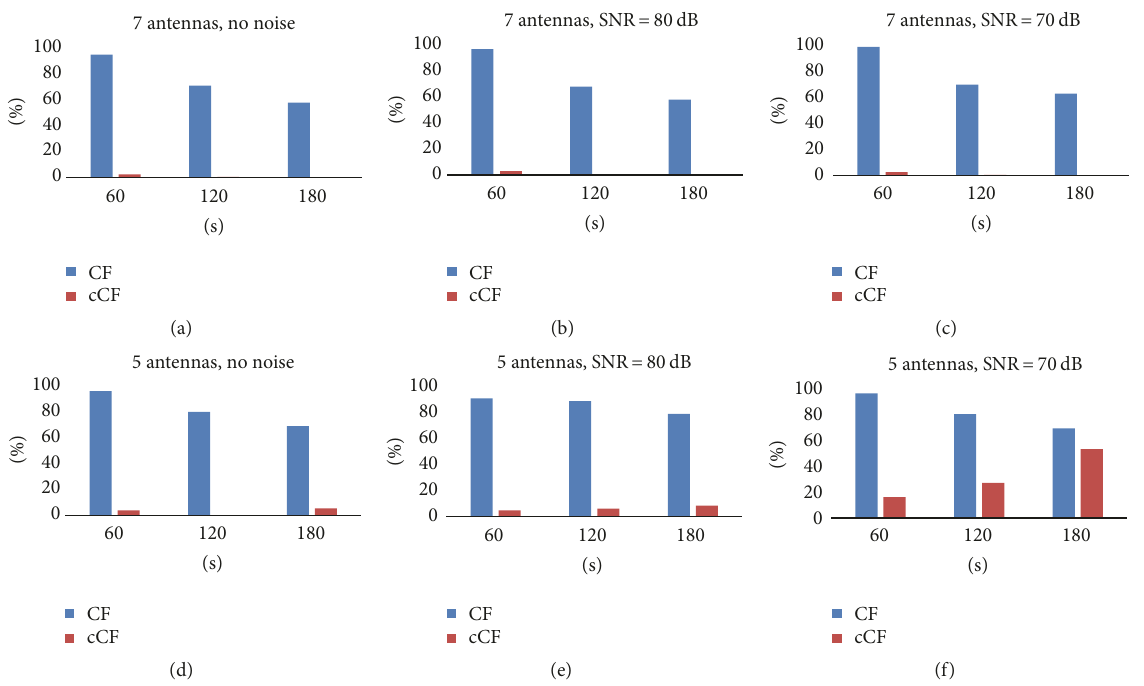
Figure 8: Normalized coverage factor of the ablated area (red) and its complement (orange) related to the fusion image reconstructions obtained with the full antenna array (a, b, c) and with reduced antennas array configuration (d, e, f). It has been considered the case of noiseless data (a, d), noisy data with SNR = 80 dB (b, e), and noisy data with SNR = 70dB (c,